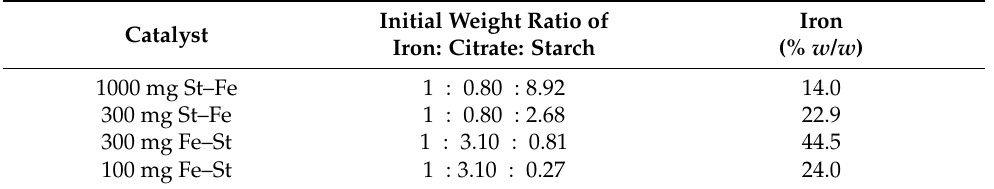
Table 2. Reagent ratios used and iron content for the catalyst systems investigated.